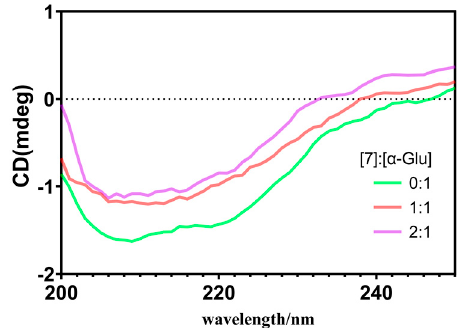
Figure5. CDspectraof α -glucosidaseinthepresenceofcompound 7 . Theconcentrationof α -glucosidase Figure 5. CD spectra of α -glucosidase in the presence of compound 7. The concentration of α - is 2 µ M. The molar ratios of compound 7 to the enzyme were 0:1, 1:1, and glucosidase is 2 μ M. The molar ratios of compound 7 to the enzyme were 0:1, 1:1, and 2:1.